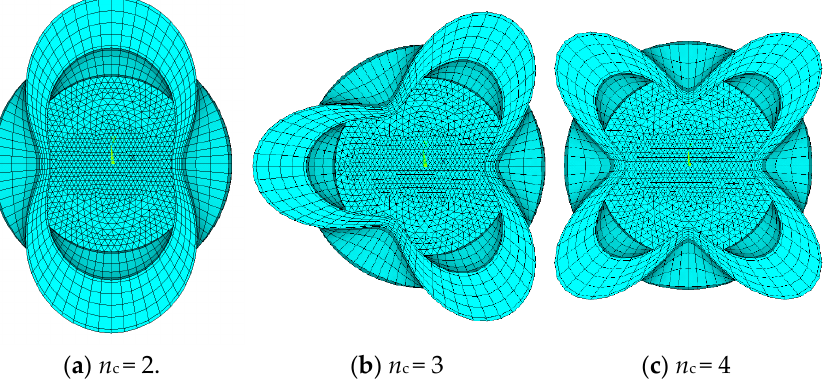
Figure 4. Half ‐ wave numbers in the circumferential direction with the value of Δ is 0.2% (scale fac ‐ Figure 4. Half-wave numbers in the circumferential direction with the value of ∆ is 0.2% (scale tor: 100). factor: 100). Table 5. Comparison results between calculation and experiment of Nc2~Nc4. Table 5. Comparison results between calculation and experiment of Nc2~Nc4. Results in [6], Case